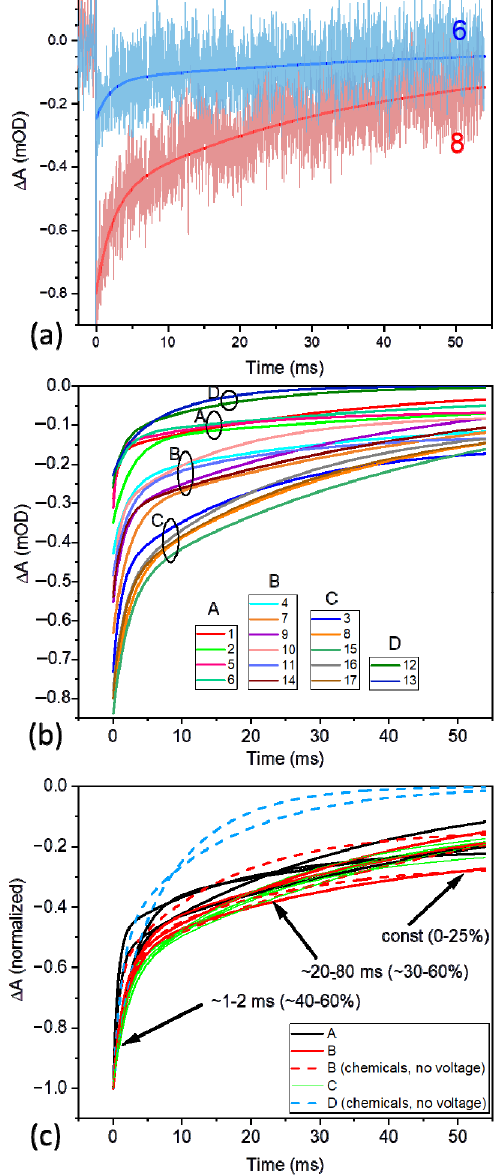
Figure 6. The kinetics of the P700 + photobleaching decay at 700 nm in the PSI complexes deposited on FTO glass. ( a ) Examples of experimental kinetics together with fitted bi-exponential curves (fit curves 6 and 8 from Table 1); the region of overlap of the two different kinetic curves is shown in dark pink; ( b ) the fit curves 1–17 from Table 1, lumped into four distinct groups (A–D); ( c ) normalized fit curves 1–17 (groups A-D from panel b are